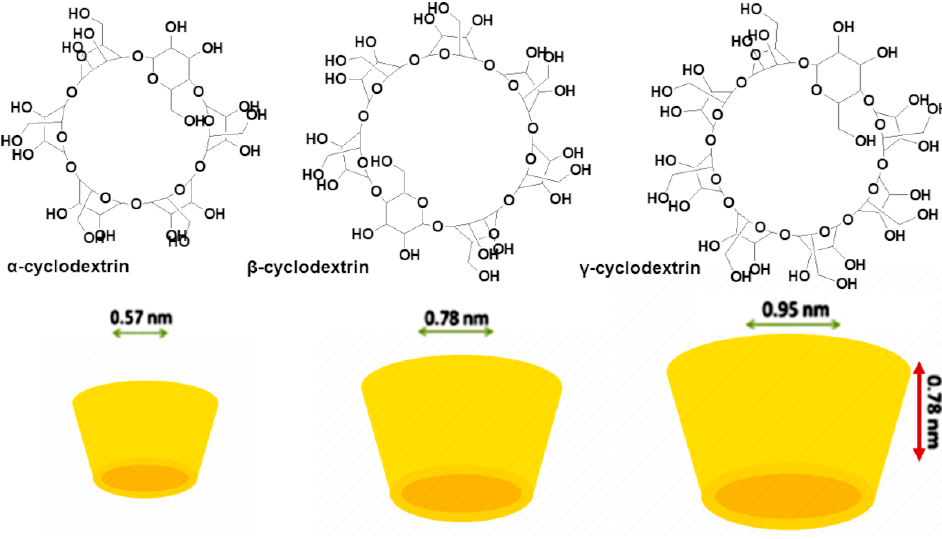
Figure 7. Chemical structure, spatial arrangement, and size of CDs.